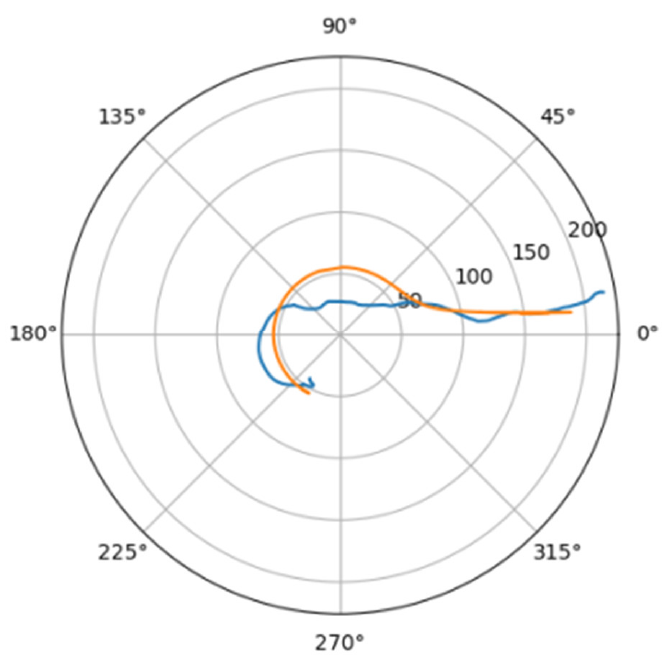
Figure 16. Approximations for zag_a.